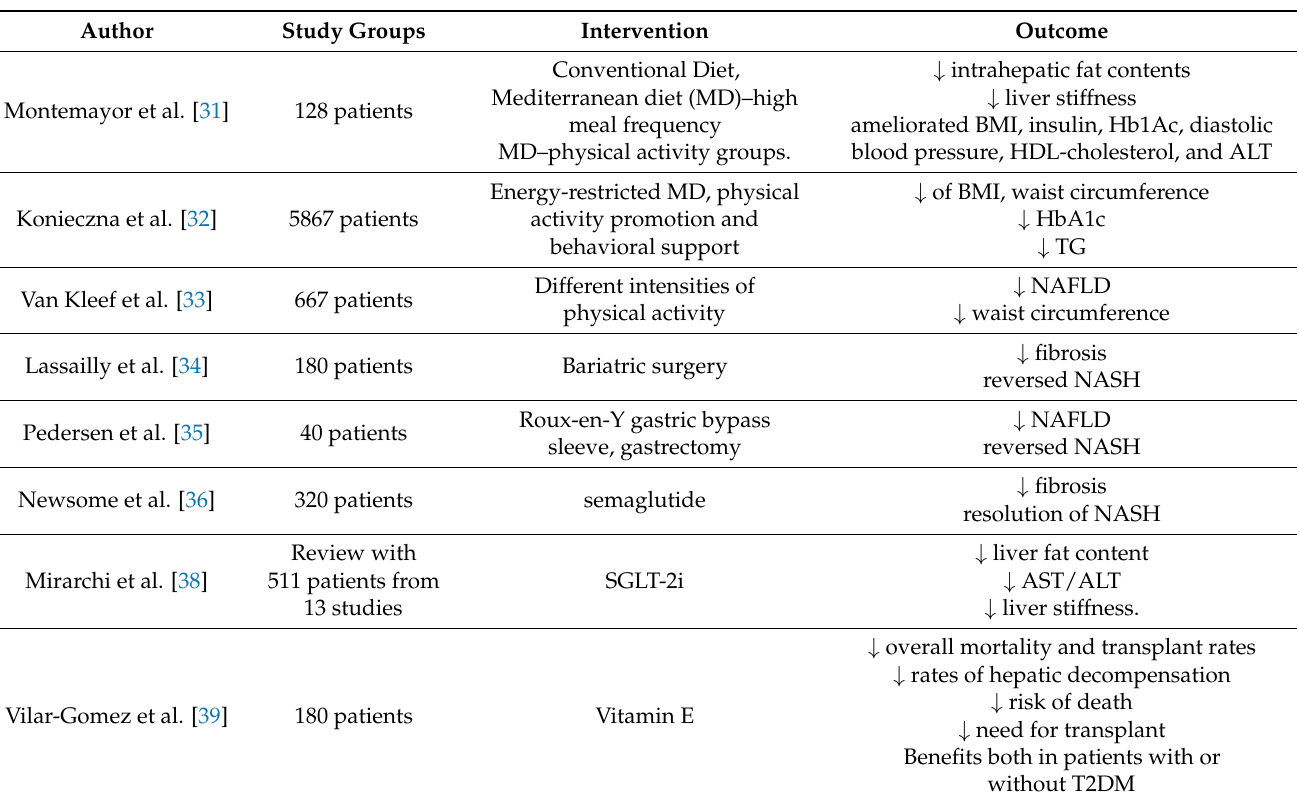
Table 1. Novel therapeutic approaches in NAFLD and